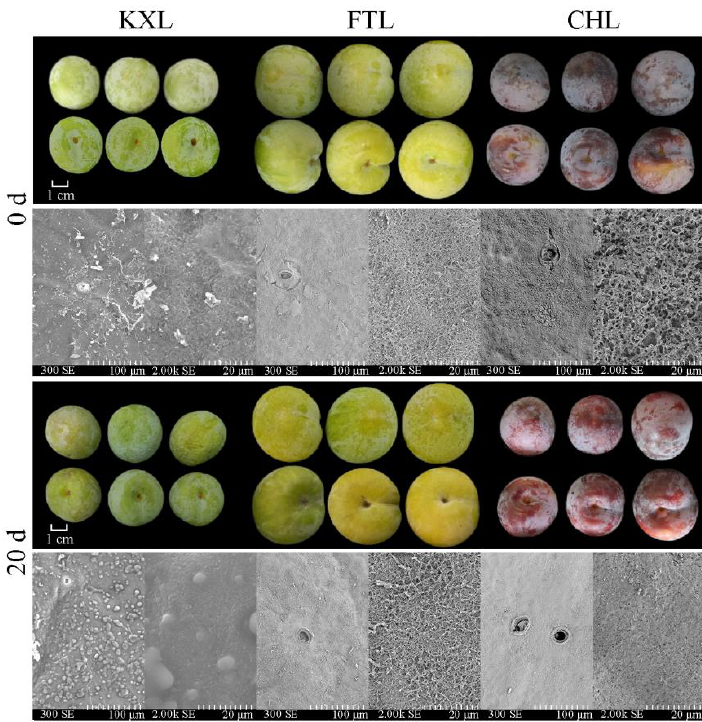
Figure 1. Changes in fruit appearance and cuticular wax structure among three plum cultivars during storage at room temperature. Note: the size of 300 SE was lenticels, and the size of 2.00 k SE was pericarp wax structure.